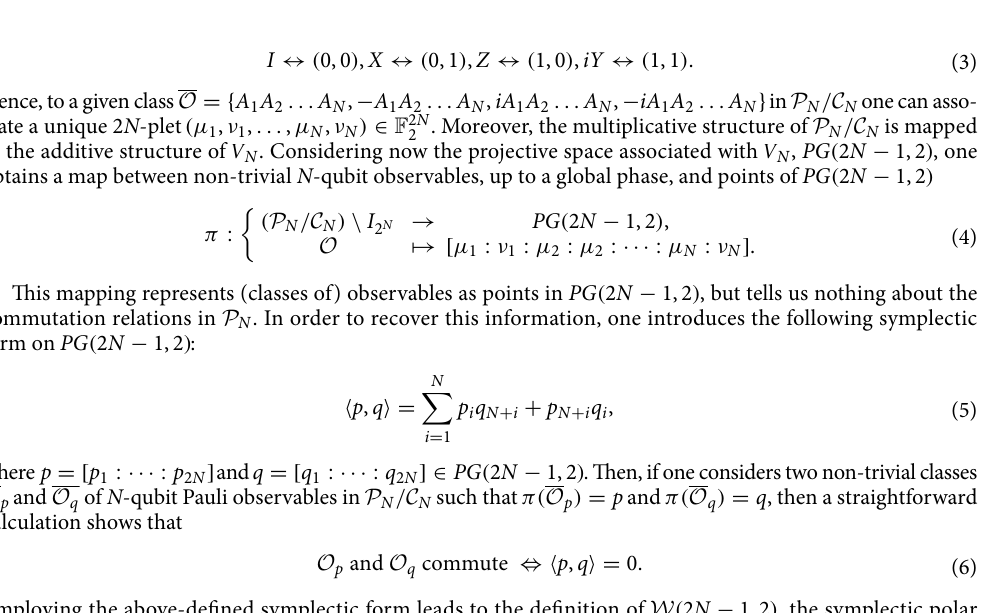
Figure 2. The Mermin pentagram 11 . Each node is labelled by a three-qubit Pauli observable. The lines of the pentagram are sets of mutually commuting observables whose product is + I 8 (each thin line) or − I 8 (the double line). The fact that there is only one (odd number) negative line allows us to use the same argument as for the Peres–Mermin magic square. This configuration therefore also furnishes a proof of the KS